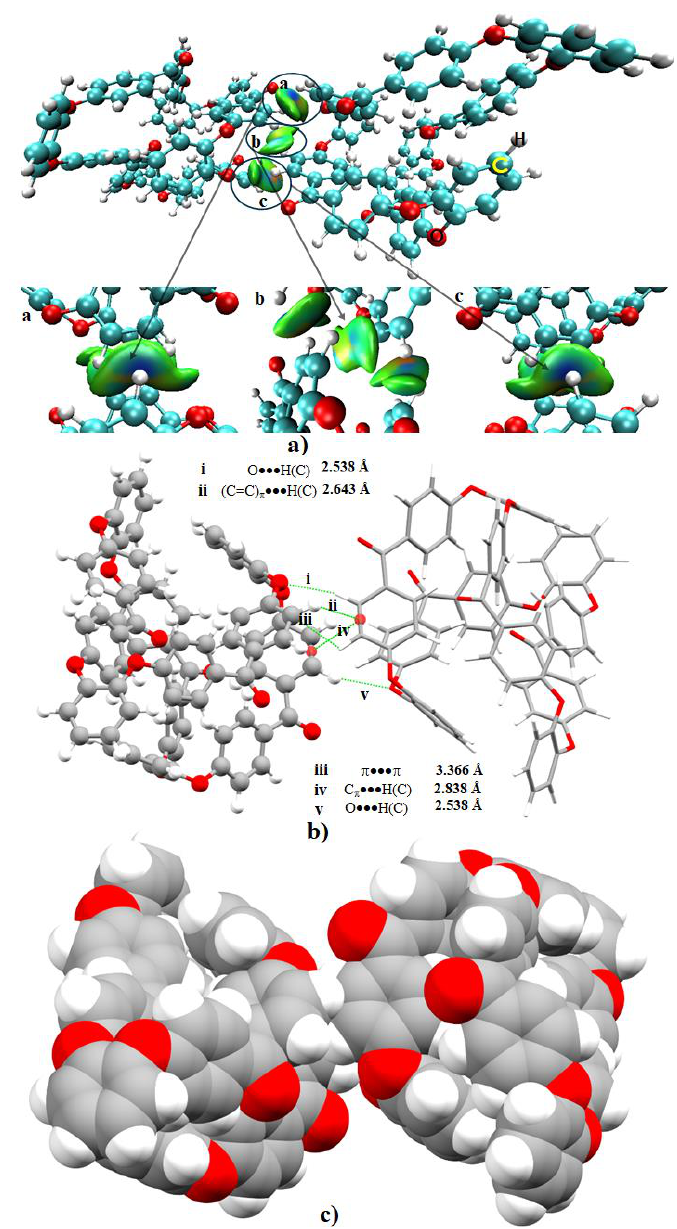
Figure 5. (a ) The result of a modified RDG-based isosurface (0.005 a.u.) analysis for the (o-PEEK) 2 complex. ( b ) The ball-stick-tube composite model of the corresponding system, showing the presence of possible intermolecular interaction distances that are marked by i)-v). ( c ) A space-filling model, showing the overlap between close-lying atomic domains.